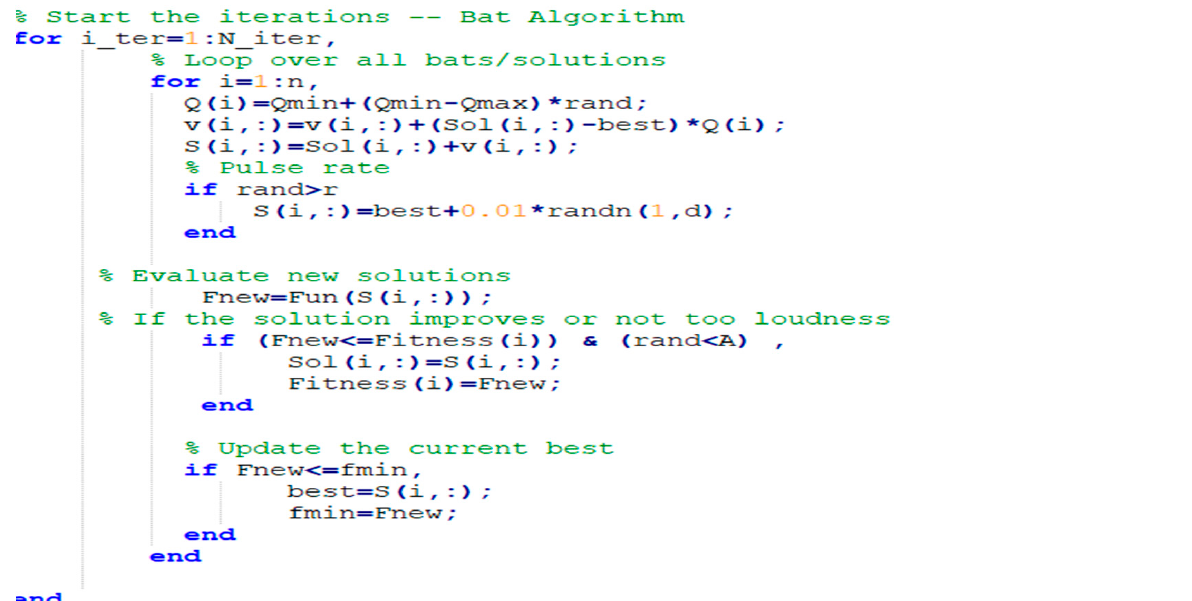
Figure 9. A Bat algorithm code sample.